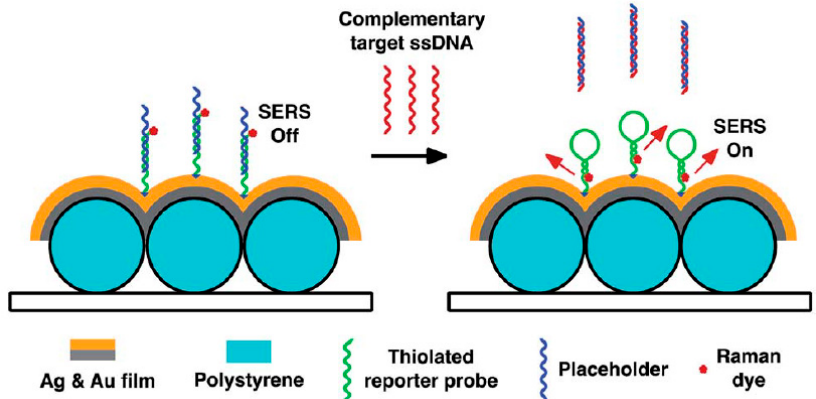
Figure 2. DNA bioassay-on-chip detection scheme (Ngo et al. [47]). SERS: Surface-enhanced Raman spectroscopy.